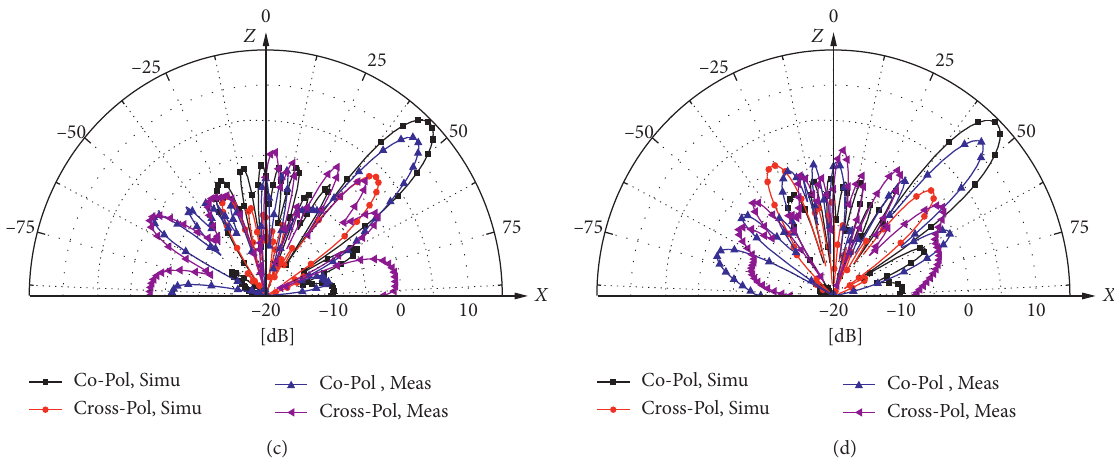
Figure 20: Measured radiation pattern with the different beam steering angles and feed ports. (a) θ xoz � 25 ° , Port 1; (b) θ xoz � 25 ° , Port